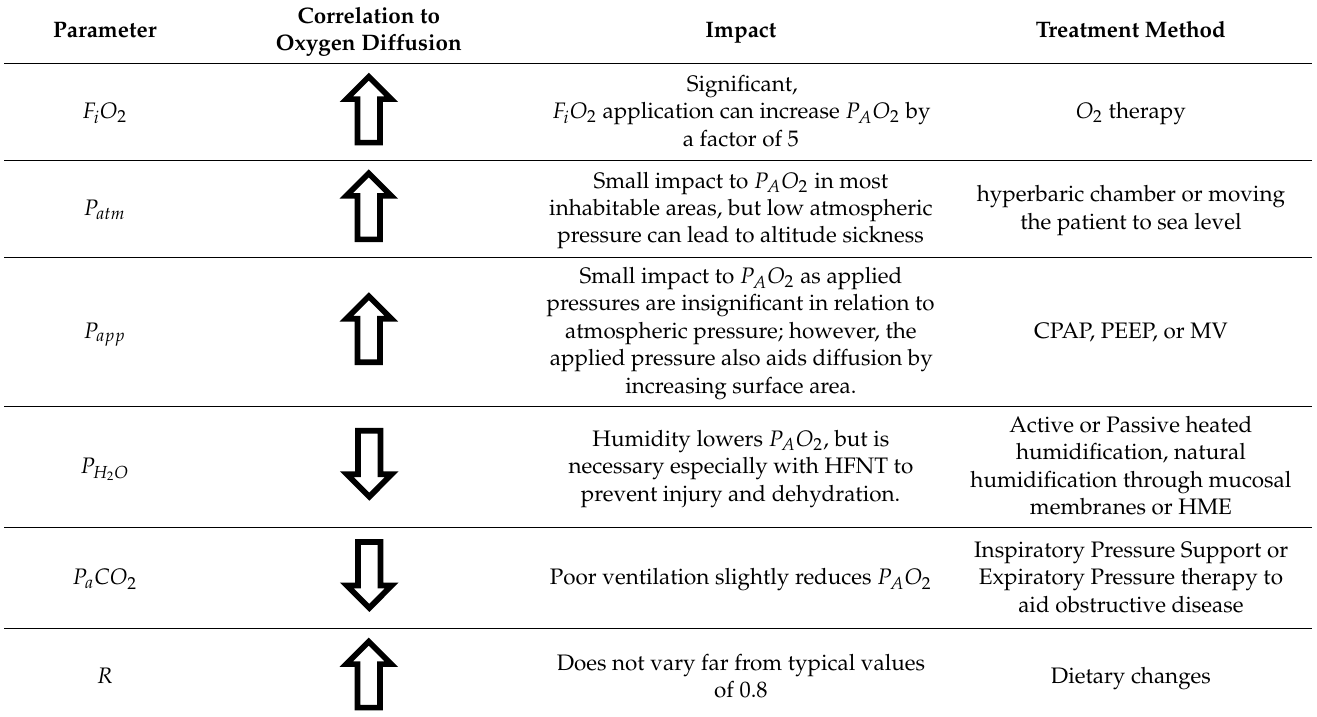
Table 1. Factors Effecting Alveolar Oxygen Pressure.